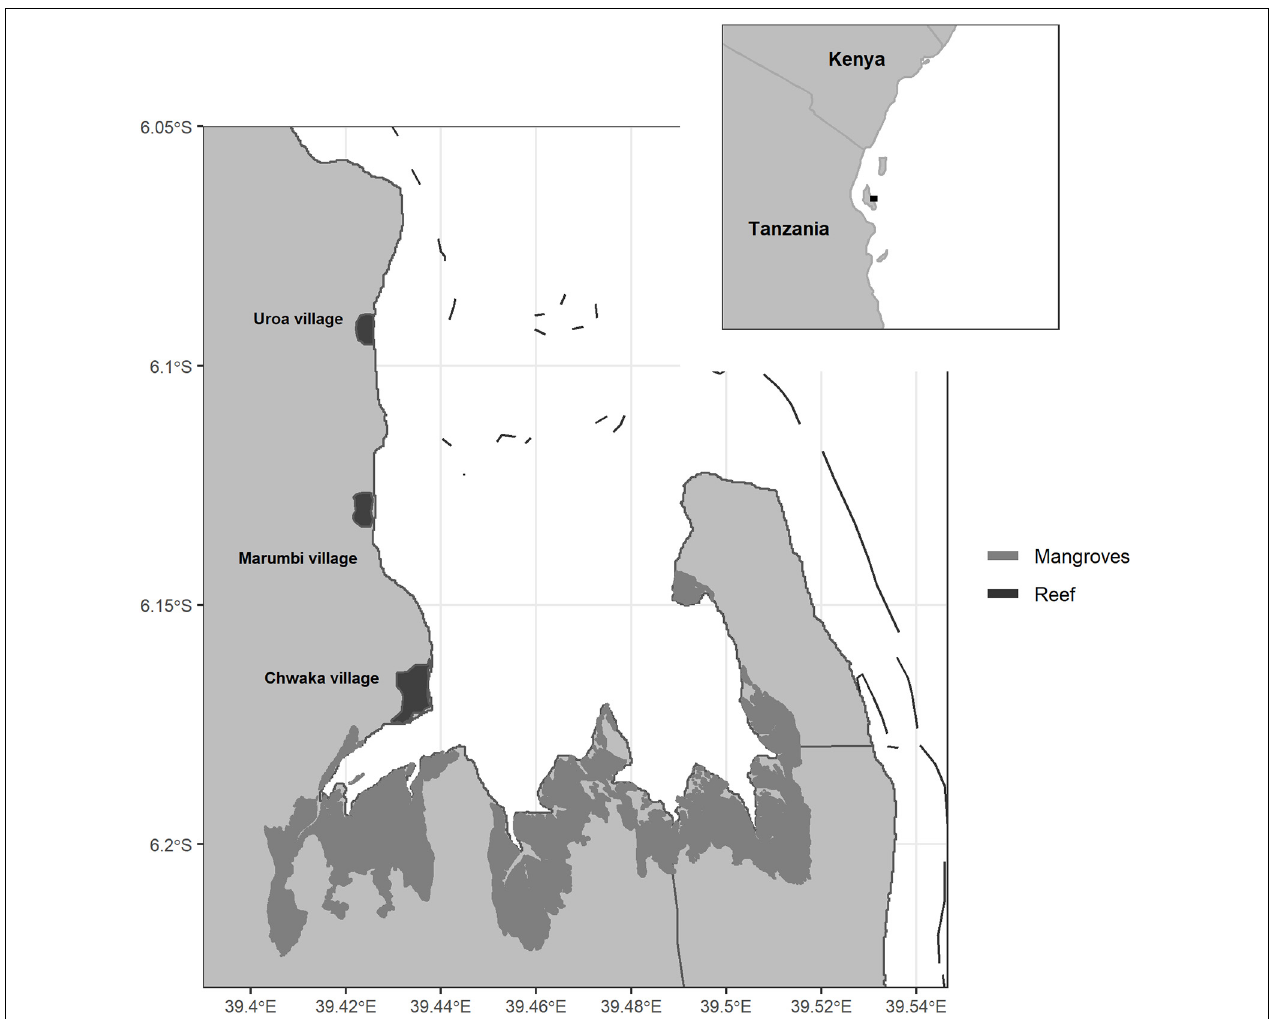
FIGURE 1 | Chwaka Bay, Zanzibar (Tanzania). The bay comprises large mangrove stands in the south, a fringing reef at the bay opening, and coral patches inside the bay. Seagrass meadows are found throughout the bay with dense aggregations toward the central